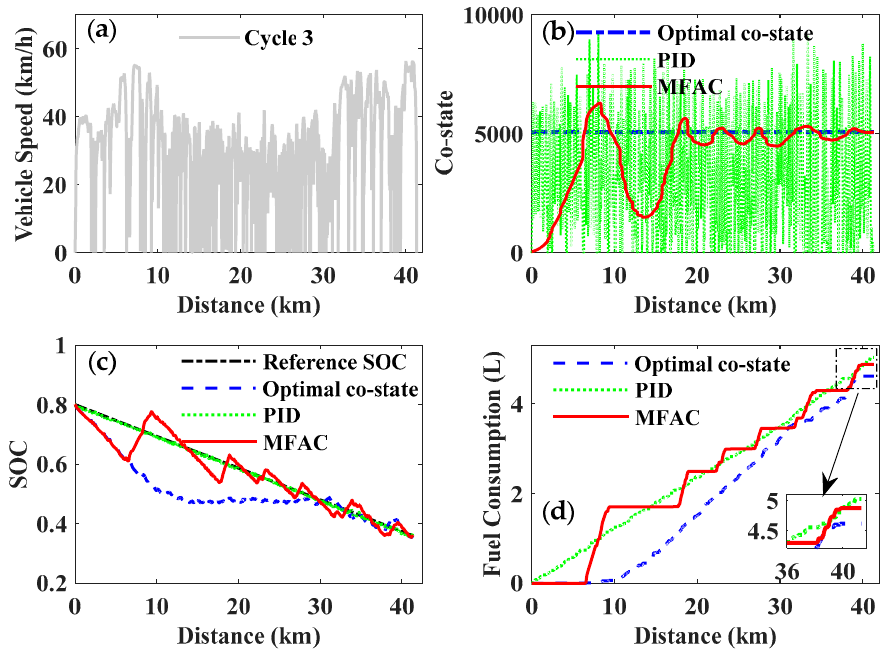
Figure 20. The simulation results of driving Cycle 3. ( a ) Driving cycle; ( b ) Co-state; ( c ) SOC; ( d ) Fuel consumption.